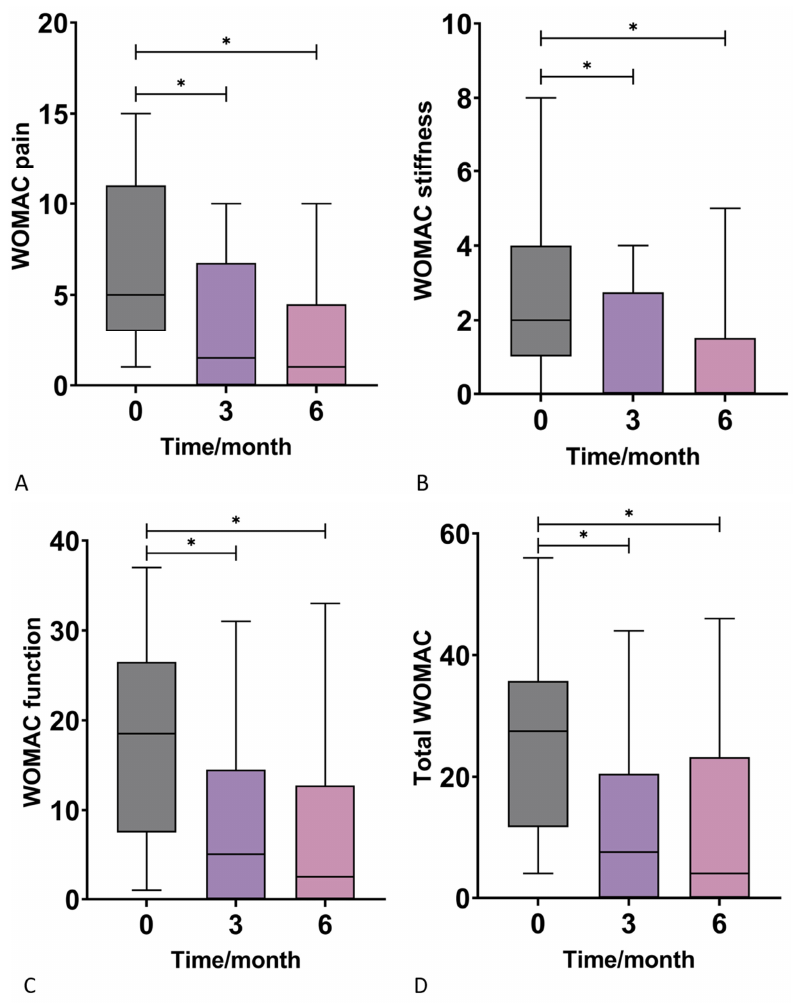
Figure 3. Box-plots show the distribution of Western Ontario and McMaster Universities Osteoarthritis Index (WOMAC) subscores for pain ( A ), stiffness ( B ), function ( C ), and the total score ( D ) at baseline and at 3 and 6 months after application of autologous conditioned adipose tissue and leukocyte-poor platelet-rich plasma. There was a significant improvement in all subscores 3 and 6 months after the therapeutic intervention compared to the baseline. *— p < 0.05 (Wilcoxon test).